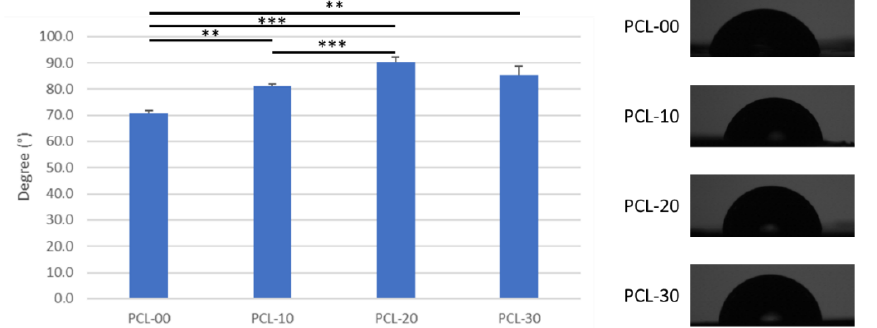
Figure 5. Wettability test of PCL with different ratios of β -TCP. Significant differences are indicated by ** for p < 0.01 and *** for p < 0.001.